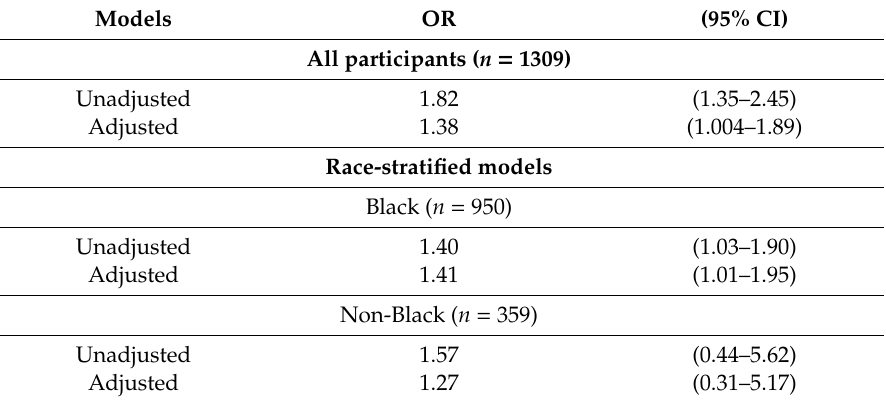
Table 4. Unadjusted and adjusted 1 associations of the highest quartile of neighborhood violent crime and high levels of individual perceived stress (PSS-14 ≥ 30), Motherhood and Microbiome cohort, n =